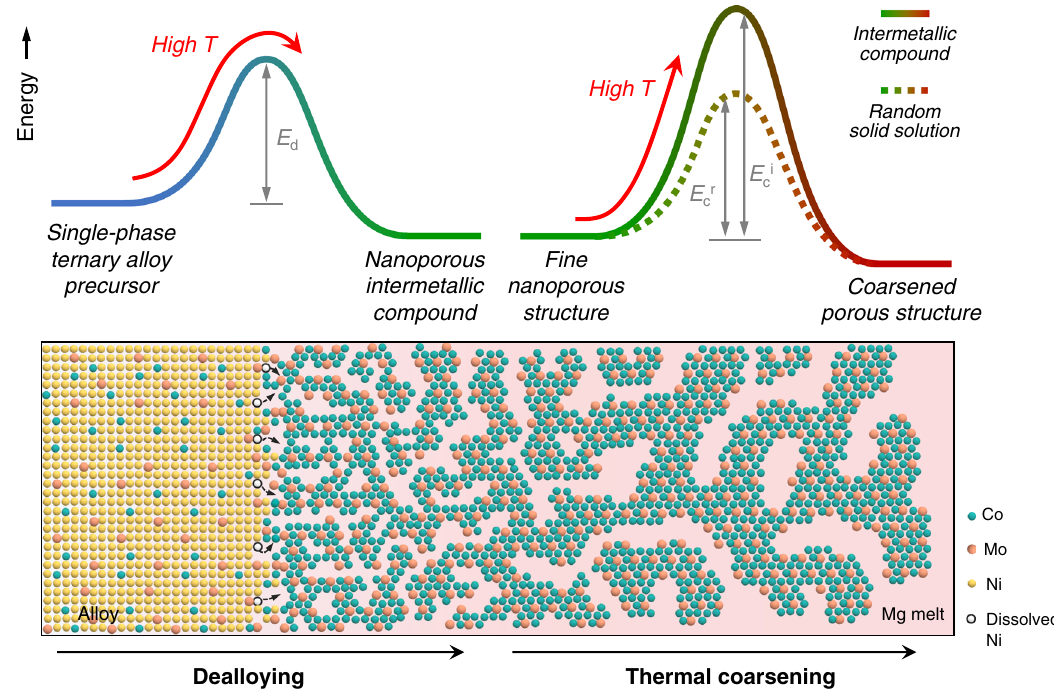
Fig. 4 | Schematic illustrations of the fabrication of ultra fi ne nanoporous μ - Co 7 Mo 6 intermetallic compound by LMD. The process involves dealloying, to create a nanoporous structure of an ordered intermetallic phase, and subsequent thermal coarsening, to increase the feature size of the porous structure. E d repre- sents the energy barrier of dealloying to form the nanoporous intermetallic